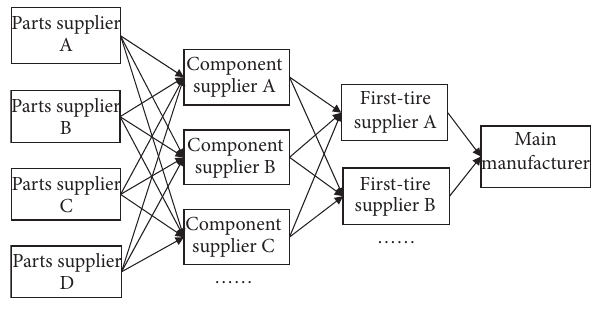
Figure 1: Complex product collaborative manufacturing supply chain network